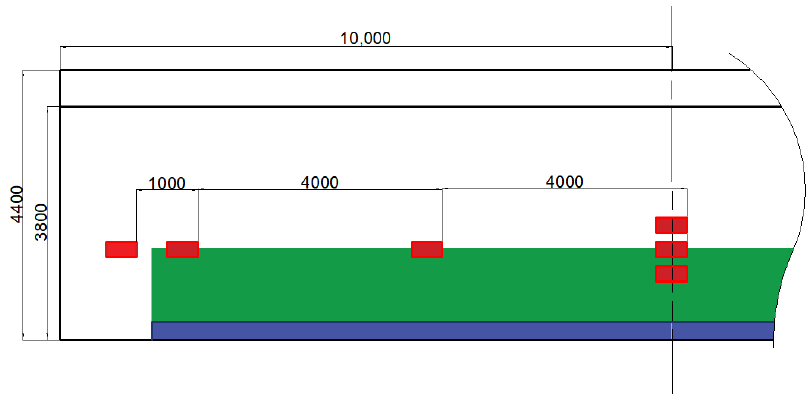
Figure 6. Position layout of UAV. Green: crops. Red: UAV. Blue: cultivation pot. Black: greenhouse.